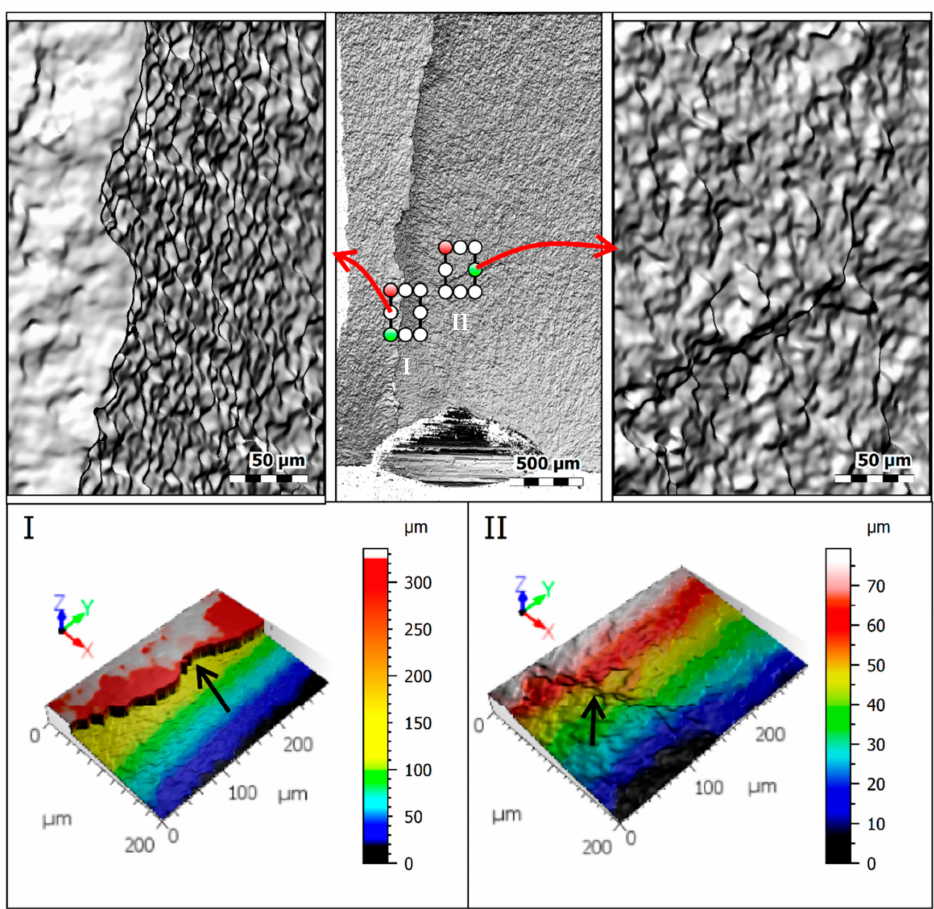
Figure 6. Fracture surface of the BT2-3 specimen near the fatigue step (Region I represents a fatigue step, and Region II represents the propagation